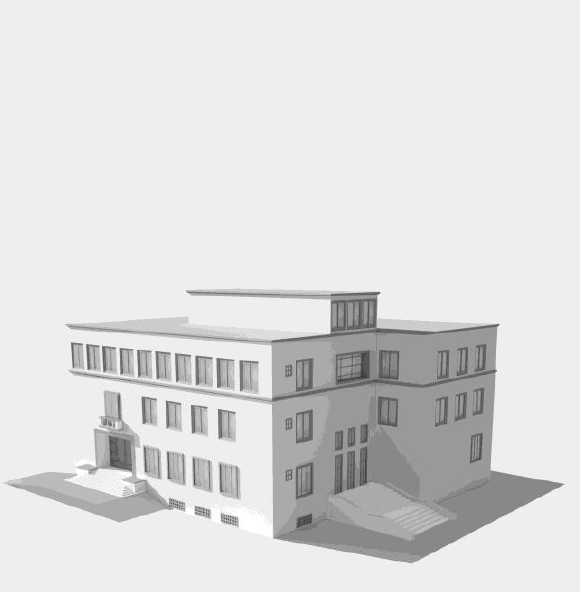
Figure 7. The Royal Park of Tirana. 3D survey of the Villa Reale.